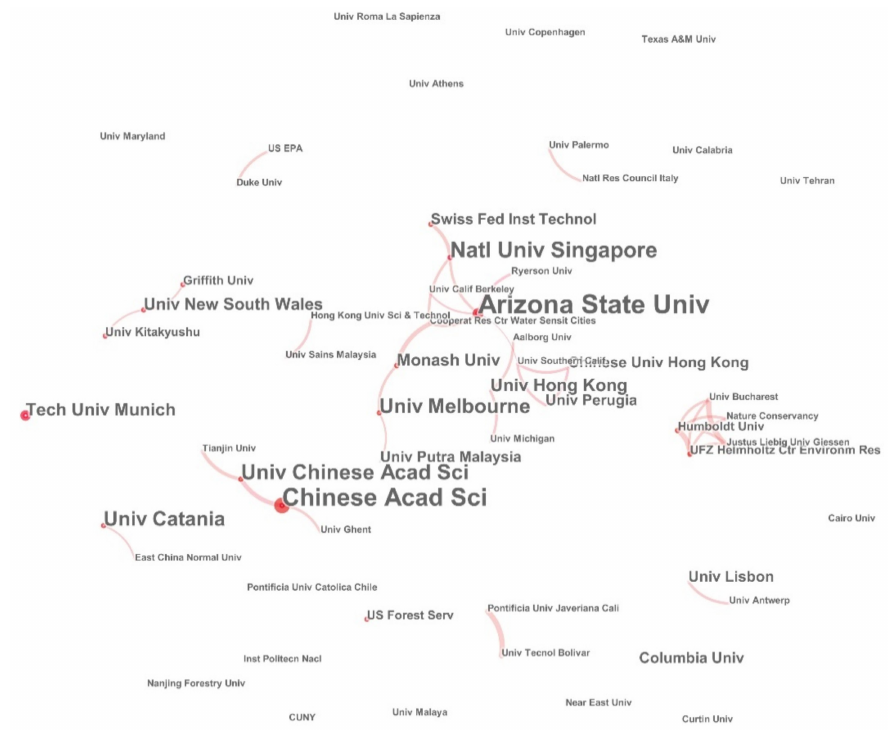
Figure 7. Distribution of